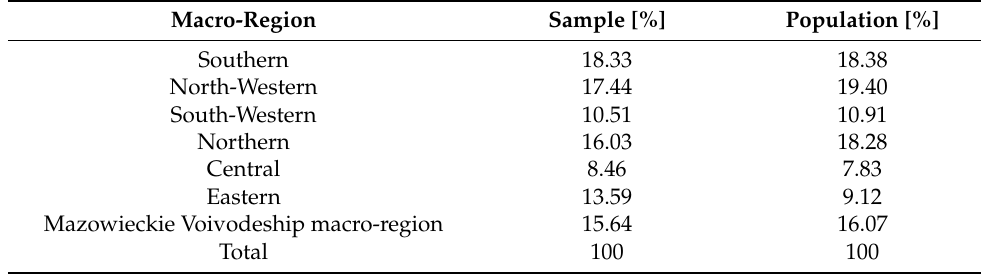
Table 1. Distribution of the enterprises in the sample vs. in the population by macro-regions. Macro-Region Sample [%] Population